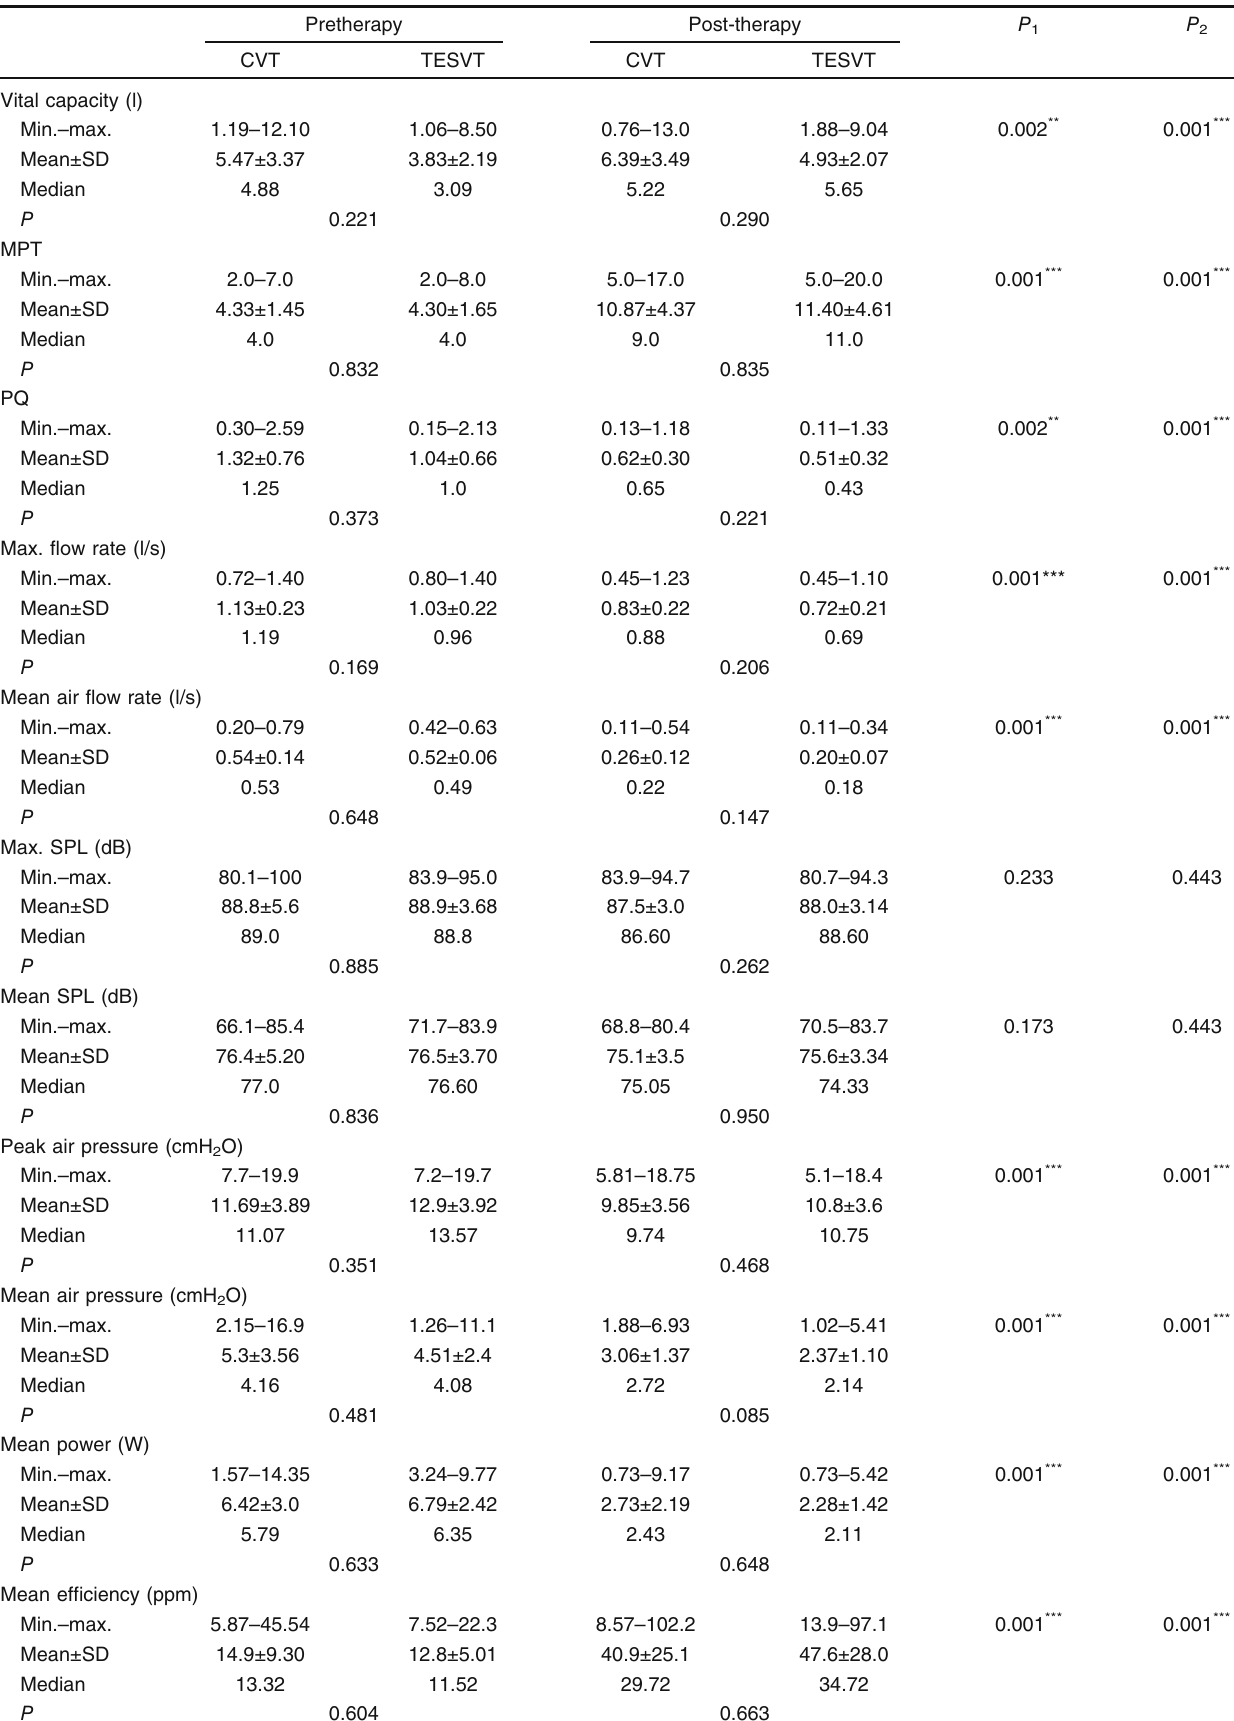
Table 5 Pretherapy and post-therapy aerodynamic analysis of both studied groups Pretherapy